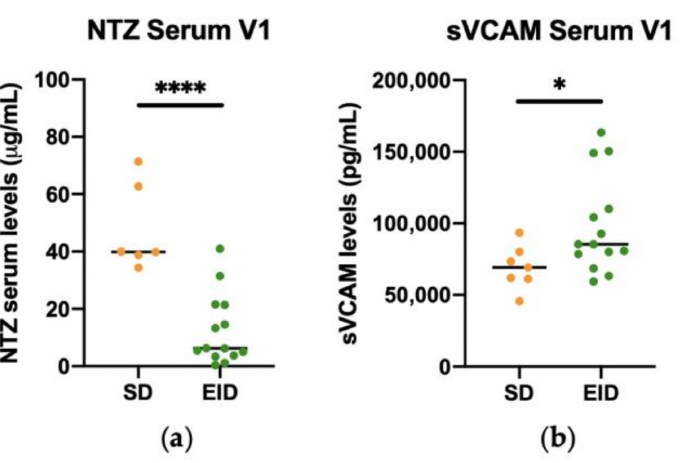
Figure 7. Representation of SD and EID groups in RRMS patients under Natalizumab treatment. Levels of ( a ) NTZ ( µ g/mL) and ( b ) sVCAM (pg/mL) in serum in the SD ( n = 7) and EID ( n = 14) groups. Each dot represents the concentration of NTZ or sVCAM in serum for each patient in the first extraction (V1). EID, extended interval dosing; NTZ, natalizumab; SD, standard dosing; sVCAM, soluble VCAM. ns: p > 0.05, * p < 0.05, **** p <